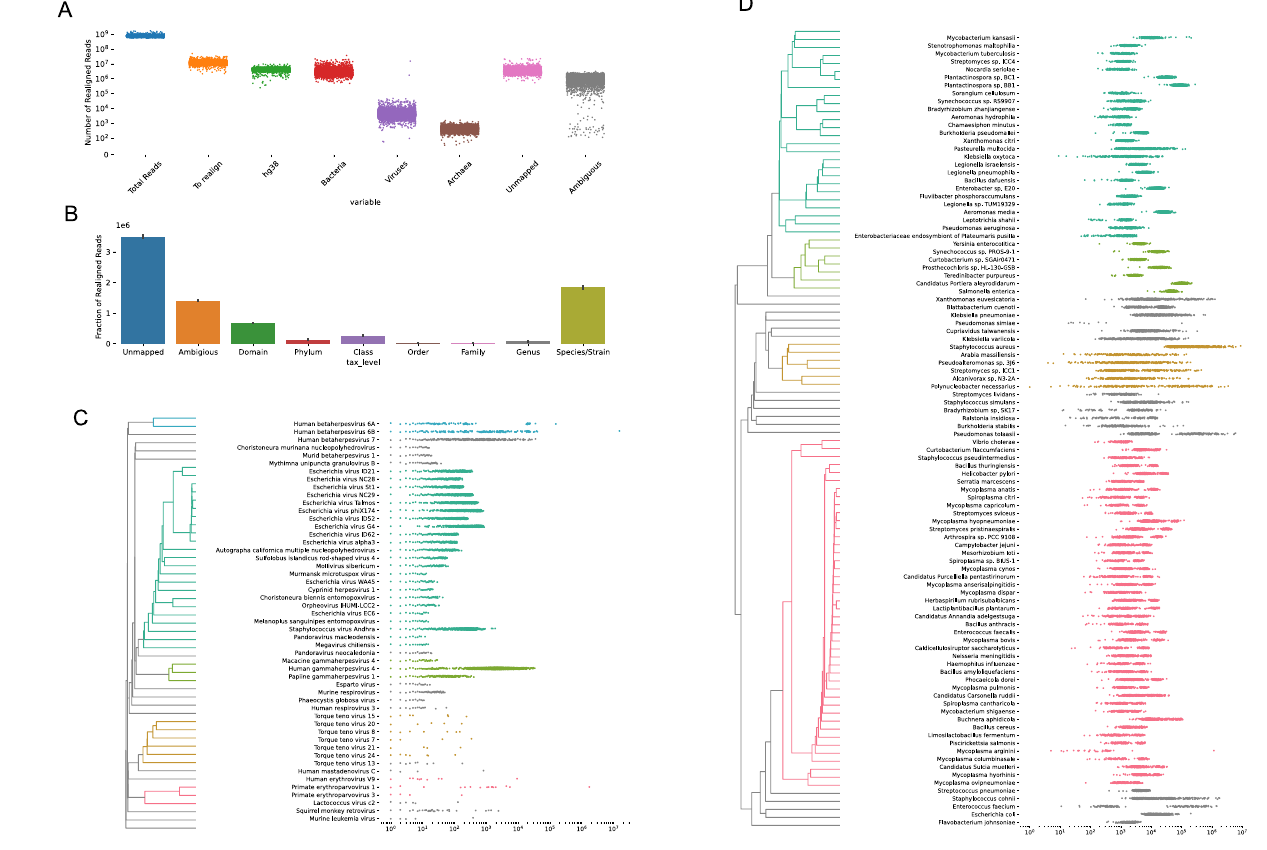
Figure 2. ( A ) Number of reads originally unmapped or poorly aligned to GRCh38 that Kraken2 classified as belonging to human, bacterial, viral, and archaeal sequences. ( B ) Taxonomic levels of Kraken2 classifications. While a significant fraction of reads were classified as ambiguous, Kraken2 was able to classify the majority of reads down to the species or strain level. ( C ) The top 50 most abundant viruses based on read count, clustered by Spearman correlation of sample abundances. Each point represents a sample’s read count. ( D ) Top 100 most abundant bacteria, archaea, and lower eukaryotes based on read counts and clustered by Spearman correlation of sample